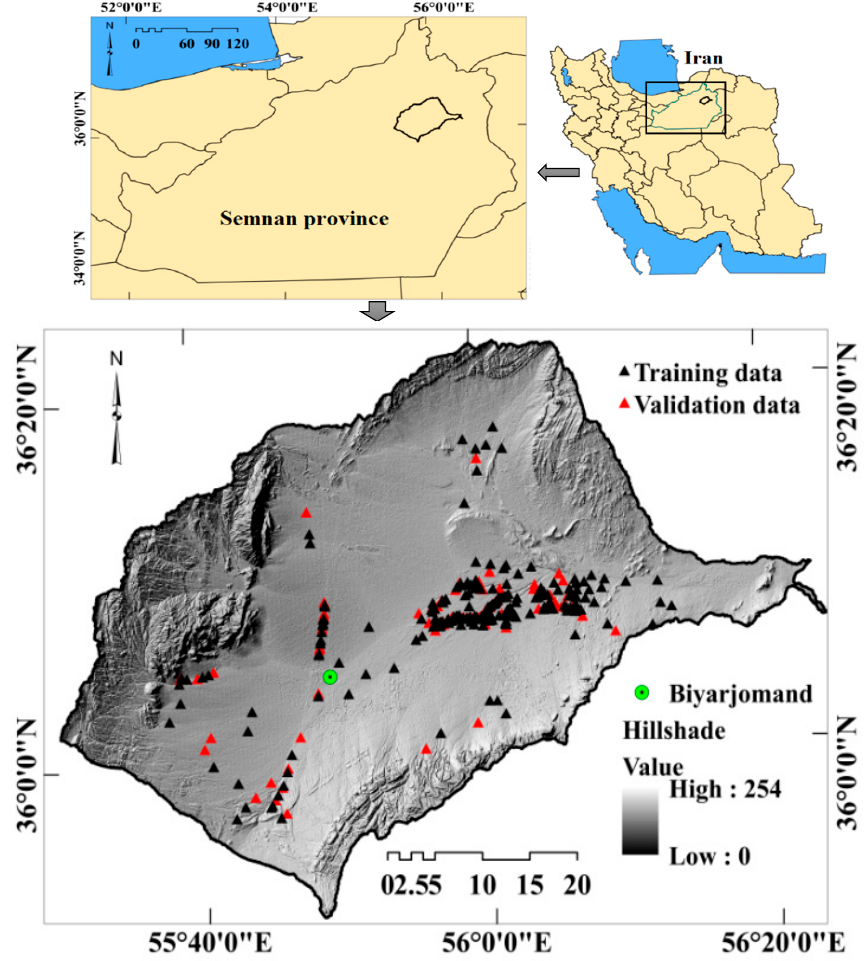
Figure 1. Location of study area in Semnan province and Iran, and location of training and validation gullies in the study area.